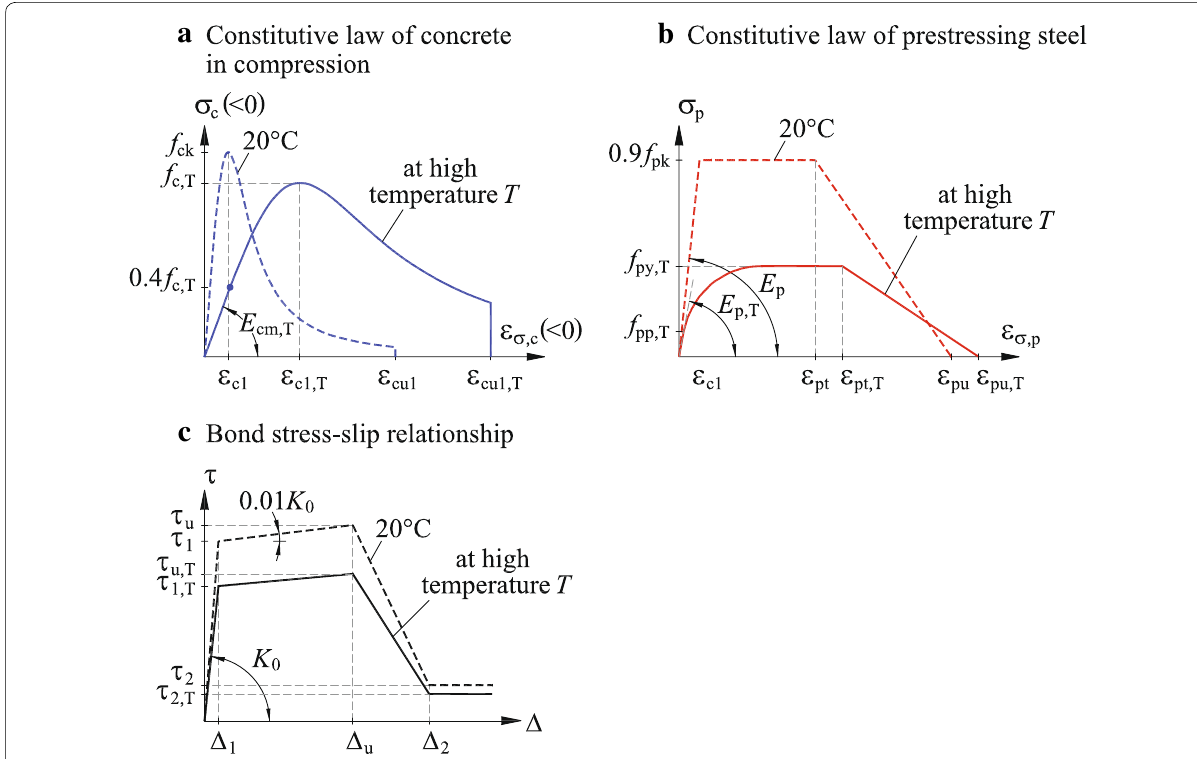
Fig. 3 Constitutive law of a concrete in compression, b prestressing steel and c bond